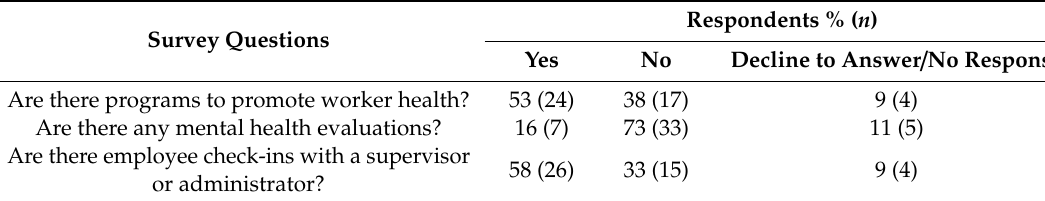
Table 4. Questions related to availability of health resources ( n = 45).